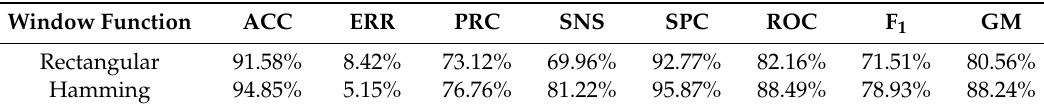
Table 6. Classification performance metrics vs. window function.